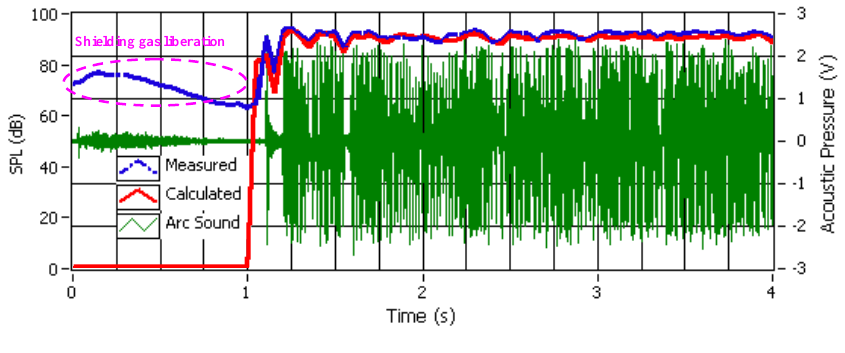
Figure 4. Acoustical Pressure and its envelope